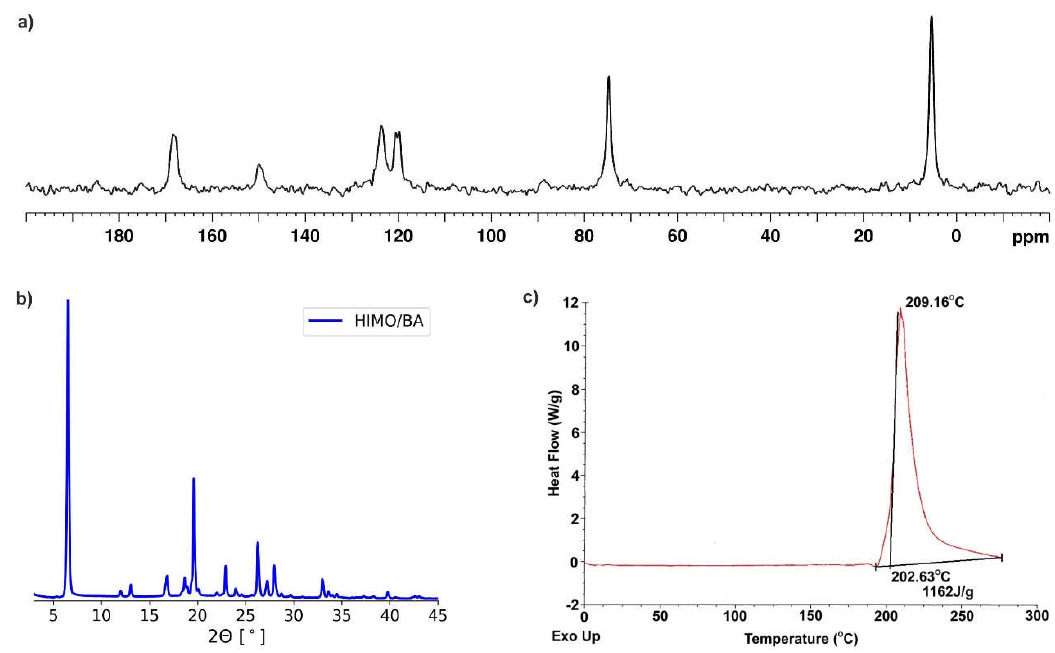
Figure 7. ( a ) 13 C CP/MAS spectrum recorded with a spinning rate of 8 kHz for BA/HIMO cocrystals obtained by cocrystallization from MeOH; ( b ) powder x-ray diffraction diffractogram for BA/HIMO cocrystal obtained by cocrystallization from MeOH; ( c ) DSC curve of BA/HIMO cocrystal. For a full analysis of the crystallographic forms of BA, HIMO and BA/HIMO based on PXRD diffractograms, see Supporting Information (Figure S3).